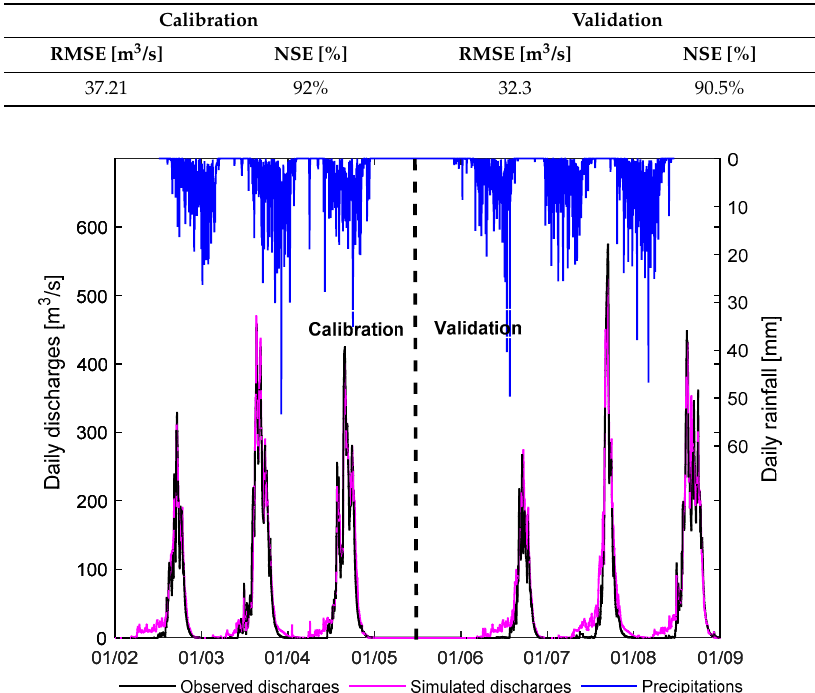
Table 3. LISFLOOD performances values.